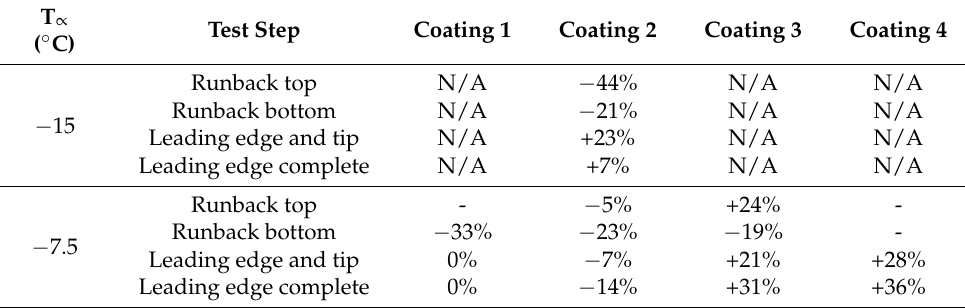
Table 4. Anti-icing power reduction compared to aluminum due to presence of coating.